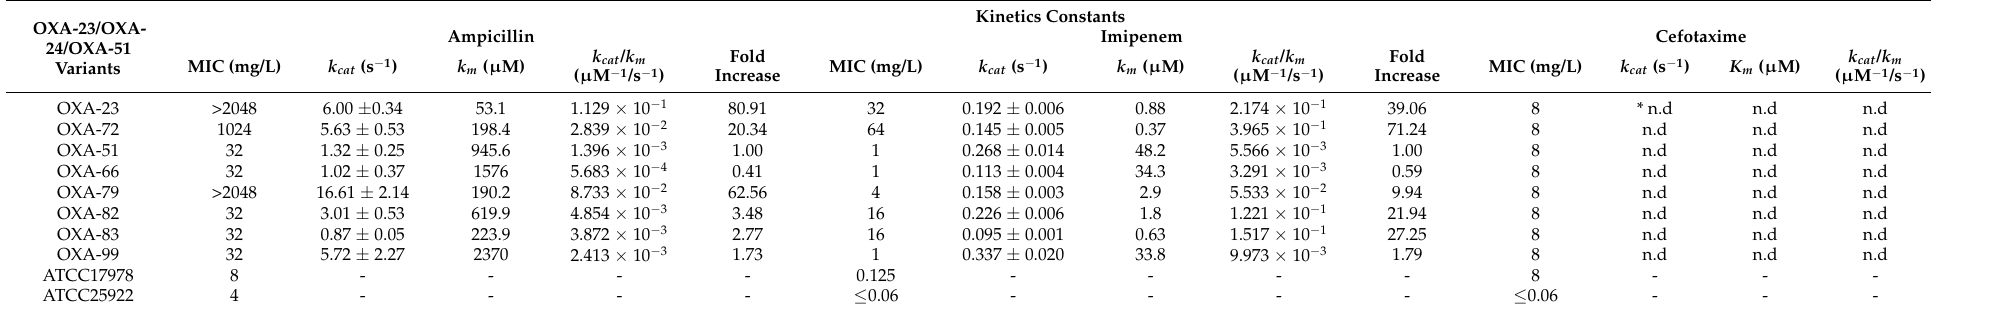
Table 2. Enzyme kinetic constants of different OXA lactamases and MIC of ampicillin, imipenem, and cefotaxime in A. baumannii strain ATCC17978 carrying these